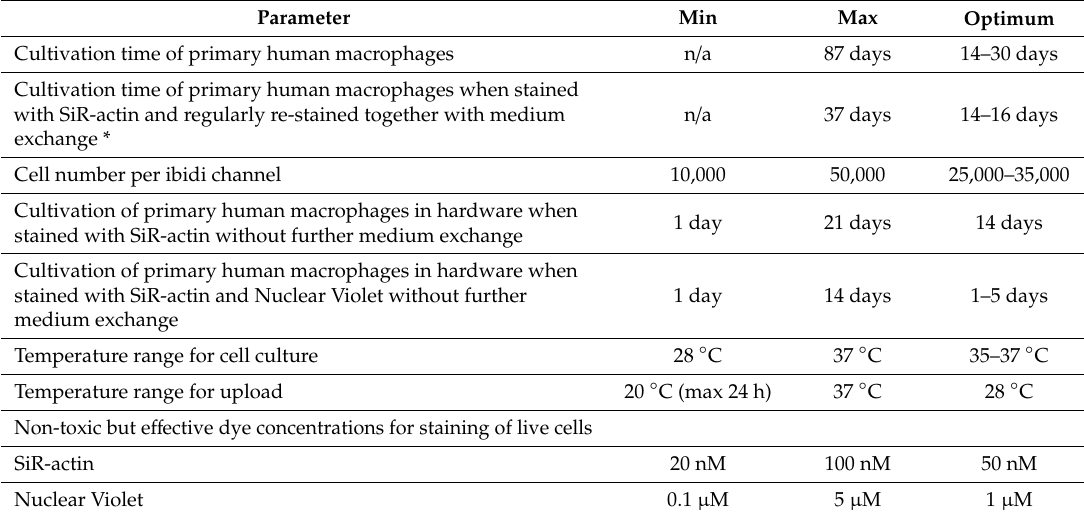
Table 1. Parameters and margins that were tested prior to the experiment. n / a: not